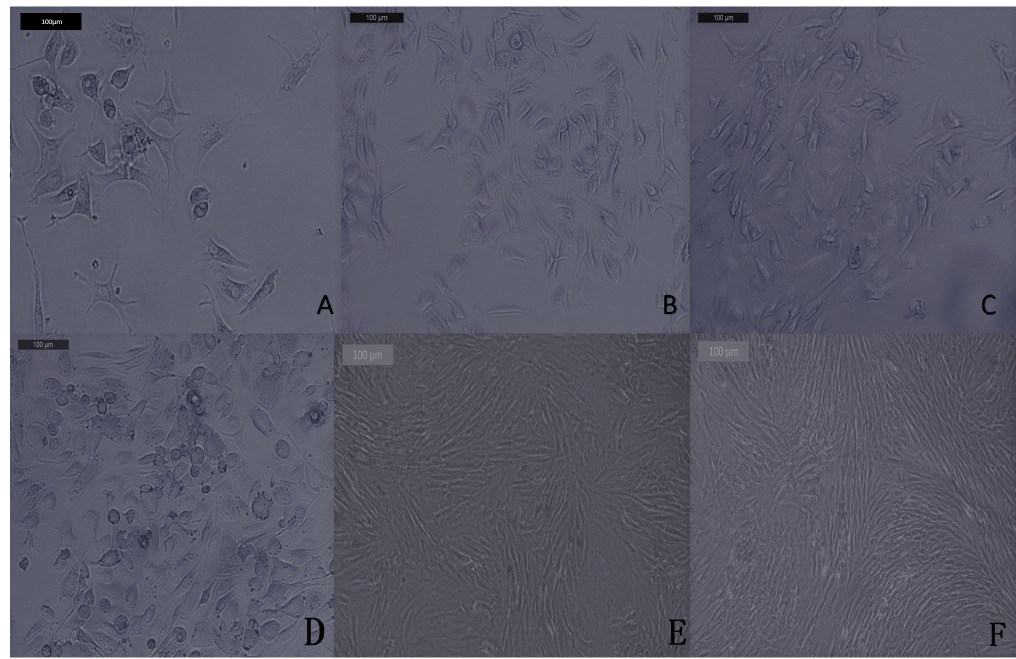
Figure 1. Isolation, morphological observation of stem cells from human exfoliated deciduous teeth through phase contrast microscopy. ( A ) Passage one shows stem cells with spindle-like morphology as grow from human exfoliated deciduous teeth pulp in few number. ( B and C ) Passages two ( B ) and three ( C ) show an increase in number of stem cells with spindle-like morphology. Isolation, morphological observation of stem cells from human exfoliated deciduous teeth in the test group through phase contrast microscopy. ( D ) Passage one shows a marked increase in number and confluency of stem cells with spindle-like morphology in comparison with control group in passage one. ( E and F ) Passages two ( E ) and three ( F ) show a pronounced, confluent and expanded SHED with fibroblast like morphology in relation to control groups of second and third passages.